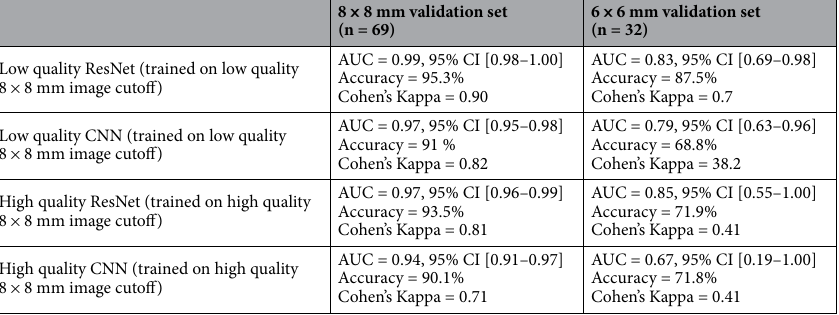
Table 2. Validation of low quality and high quality ResNet models trained on 8 × 8 mm images against 8 × 8 mm and 6 × 6 mm OCTA superficial slab images shows robust quality assessment. AUC area under the curve.